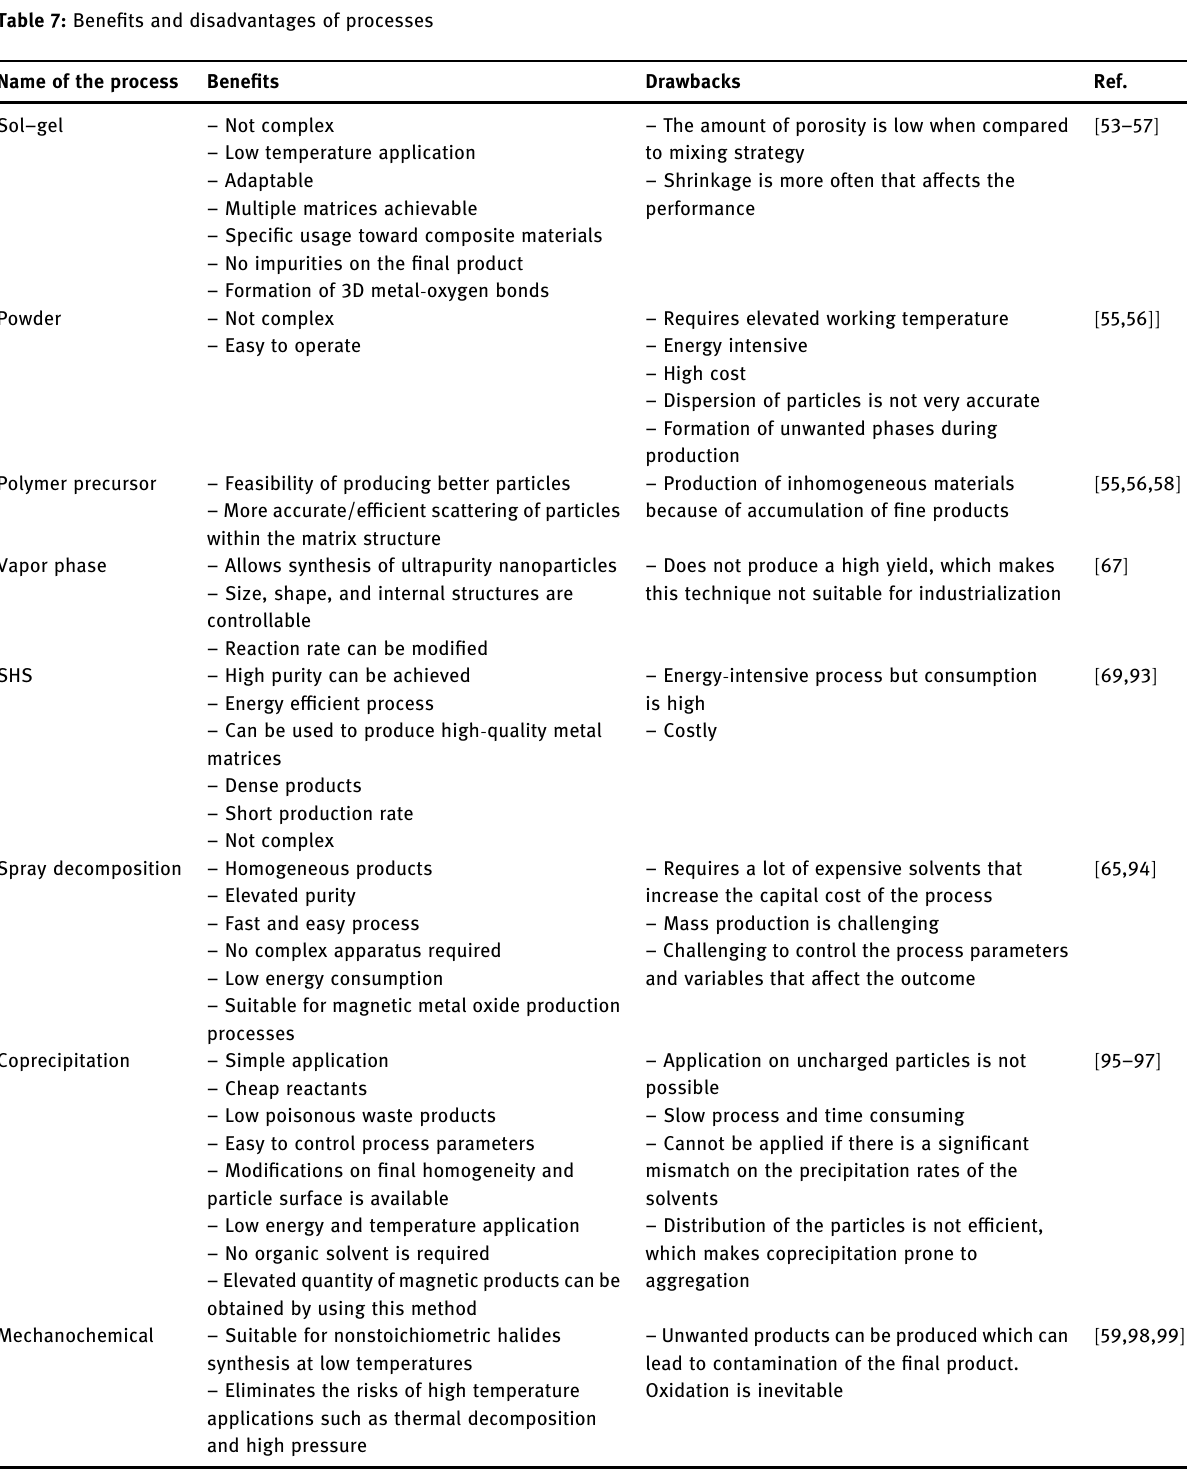
Table 7: Bene fi ts and disadvantages of processes Name of the